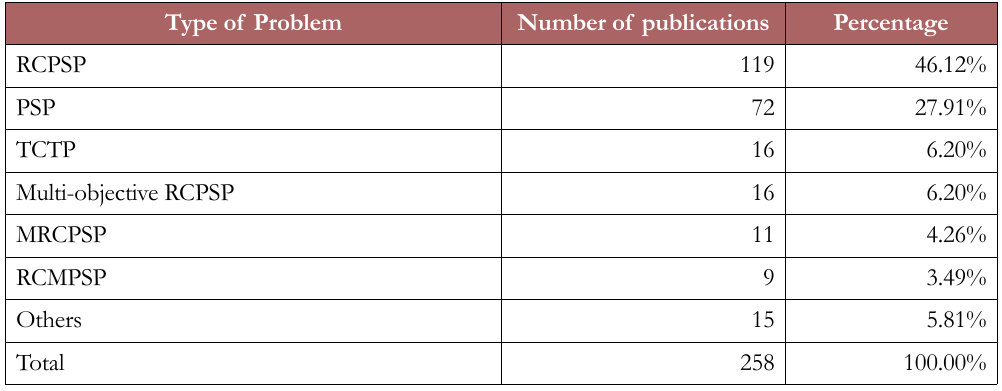
Table 3. Type of problem analyzed by